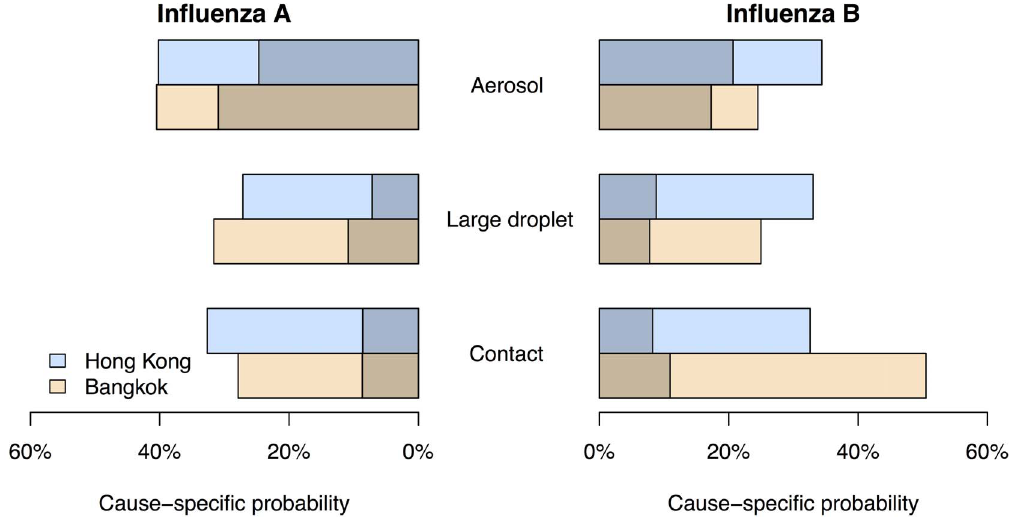
Figure 3. The proportion of all influenza A and B virus infections attributed to each mode in the control arms of the studies in Hong Kong (blue) and Bangkok (brown), and the infections associated with fever plus cough (darker shade) or not associated with fever plus cough (lighter shade). Data shown on influenza A were extracted from a previous study [9]. The contributions of the three modes sum to 100% within each geographic location and influenza